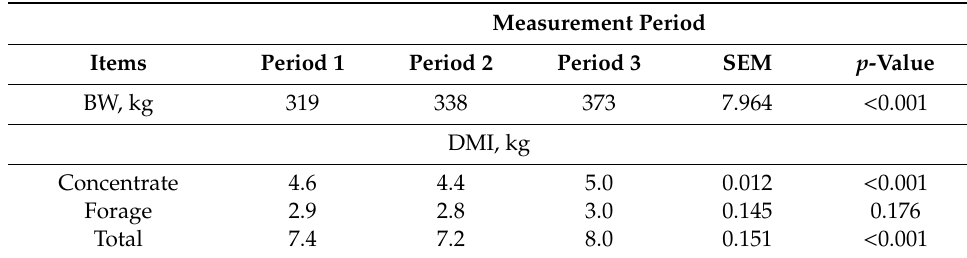
Table 3. BW and feed intake of each measurement period.